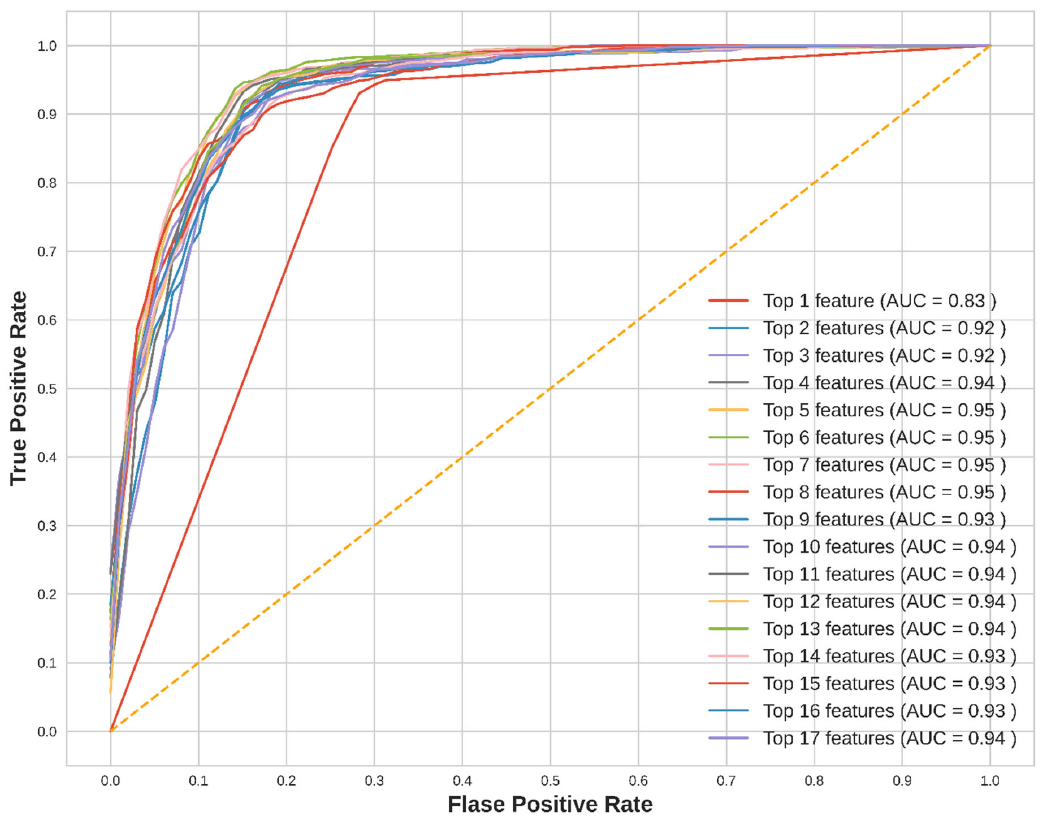
Figure 3. The ROC curves for the top 1 to top 17 ranked features using XGB feature ranking and LR classifier.